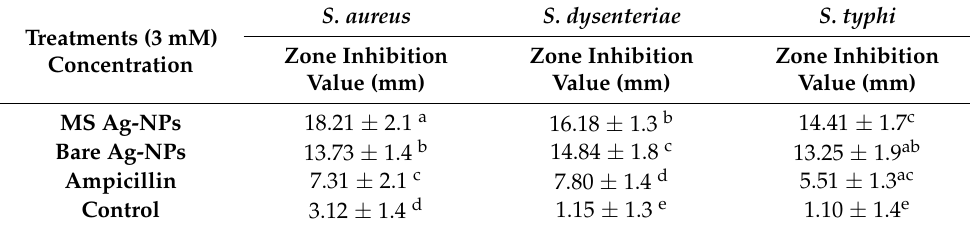
Figure 8. Optical density of the MS-AgNPs determined the growth of the bacteria in liquid broth at different time intervals (8, 16, 24 h). (A) Representative growth of the bacteria in liquid broth at 8 h, (B) representative growth of the bacteria in liquid broth at 16 h, and (C) representative growth of the bacteria in liquid broth at 24 h. Note: *** shows significant difference at p < 0.05, ** shows signif- icant difference at p < 0.01, and * shows significant difference at p < 0.005. 3.4. MS-AgNP’s Effect on Bacterial Membrane The zeta potentials of the S. aureus , S. dysenteriae , and S. typhi were measured to ex- amine the effect of the MS-AgNPs on the membrane surface of the bacteria. Our results showed that untreated cells of S.aureus, S.dysenteriae, and S.typhi revealed a zeta potential